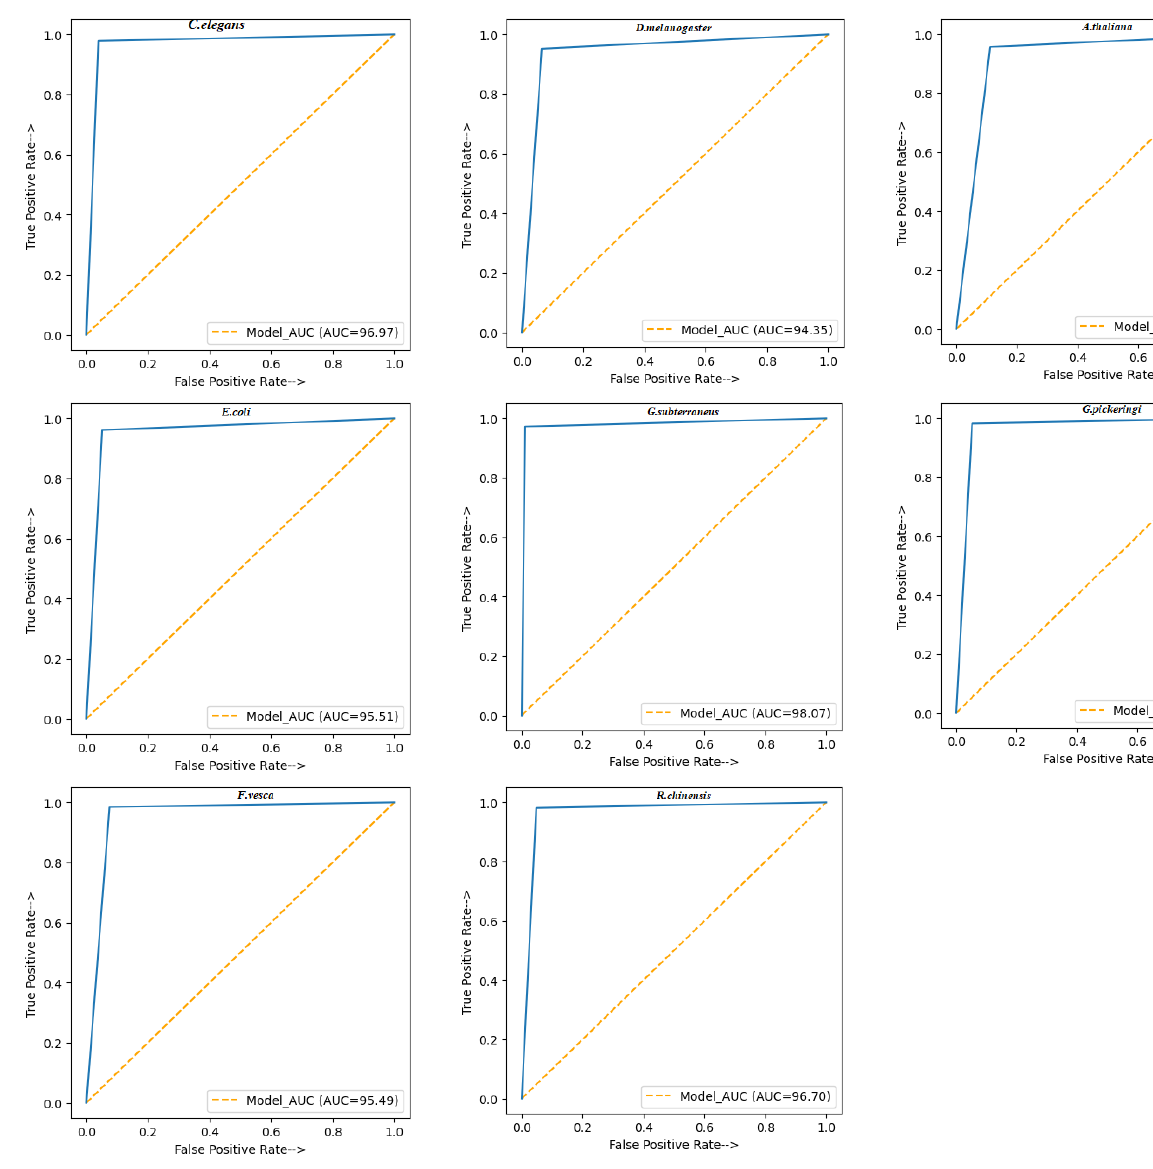
Figure 3. ROC curve and AUC of the proposed model. In Figure 3, the blue dots represent the True Positive Rate (TPR) at different classifi- cation thresholds, while the orange dots represent the AUC of this proposed model. The proposed model obtained AUC values of 96.97, 94.35, 92.30, 95.51, 98.07, 96.49, 95.49, and 96.70 for the C. elegans , D. melanogaster , A. thaliana , E. coli , G. subterraneus , G. pickeringi , F. vesca , and R. chinensis datasets, respectively. That is, the proposed model has 96.97%, 94.35%, 92.30%, 95.51%, 98.07%, 96.49%, 95.49%, and 96.70% probability of distinguishing 4mC from non-4mC for each dataset, respectively. The results of other performance eval- uation matrices are shown in Table 6.